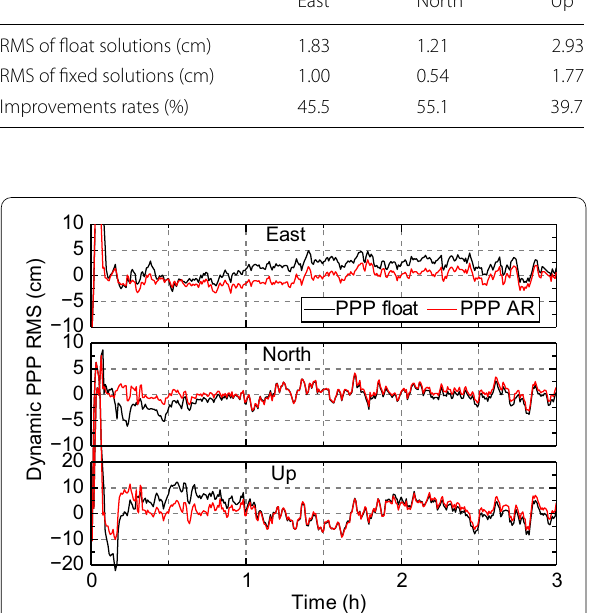
Fig. 13 Kinematic PPP positioning errors at YARR station